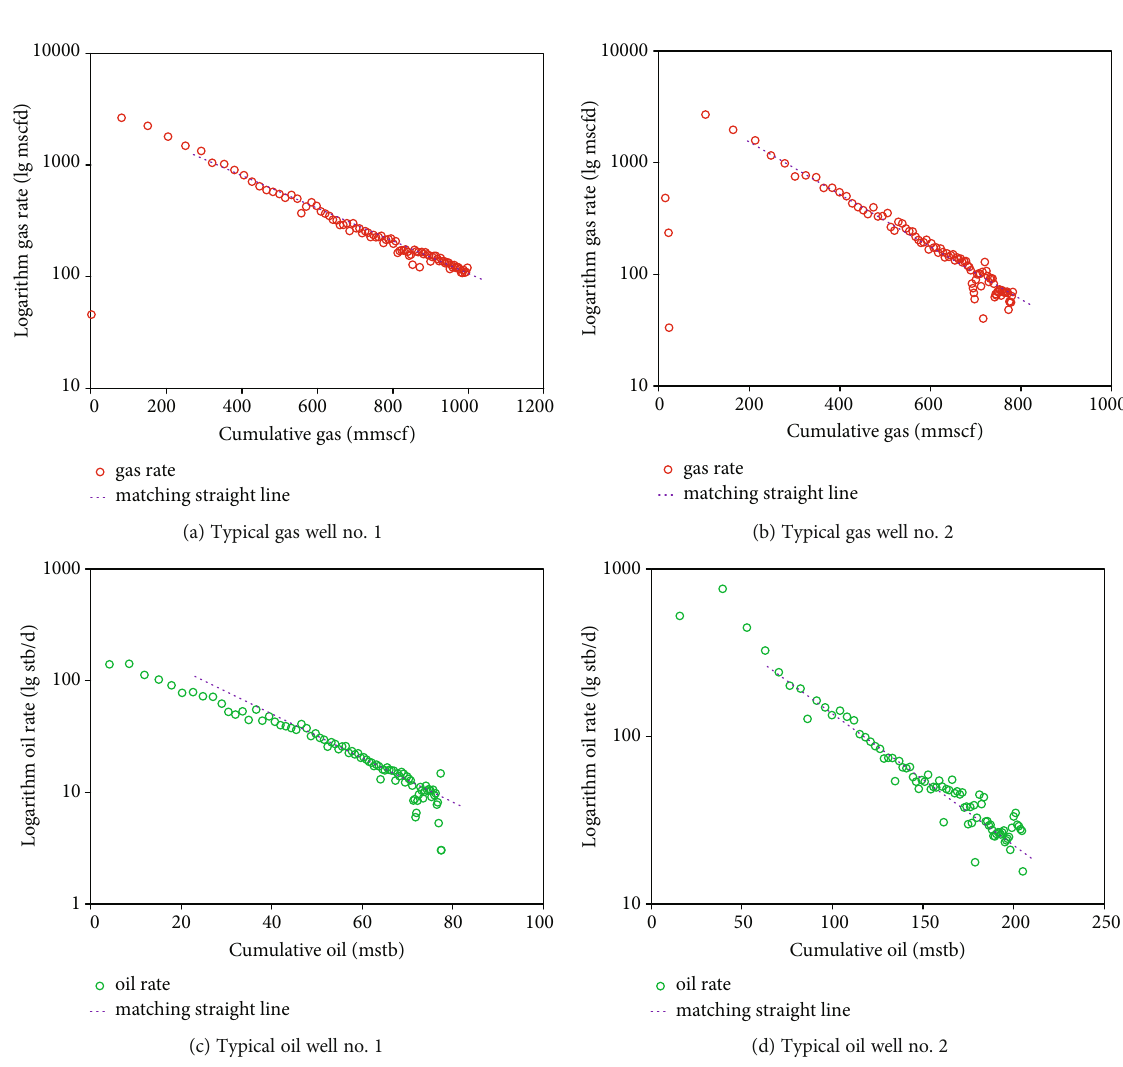
Figure 3: Typical production date of Eagle Ford